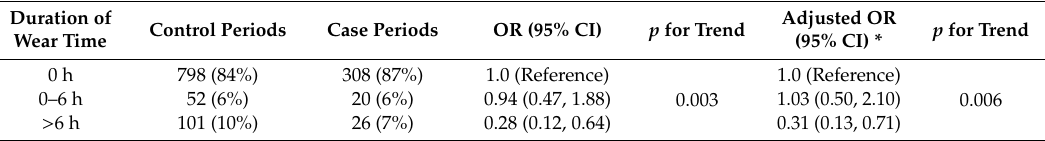
Table 3. Association between duration of time wearing shoes with a heel height ≥ 2.5 cm over the past 24 h and pain exacerbation ( n =